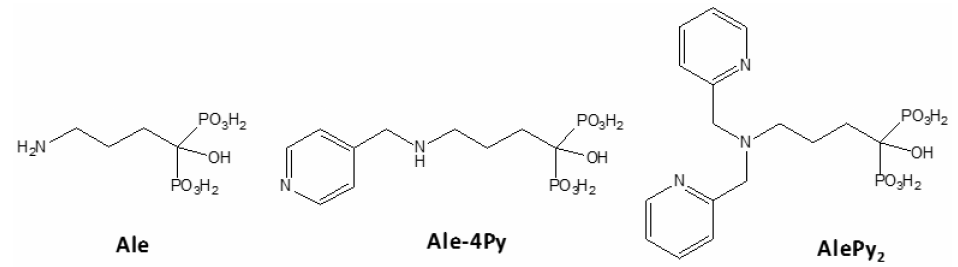
Scheme 1. Structure and abbreviations of the ligands used in this